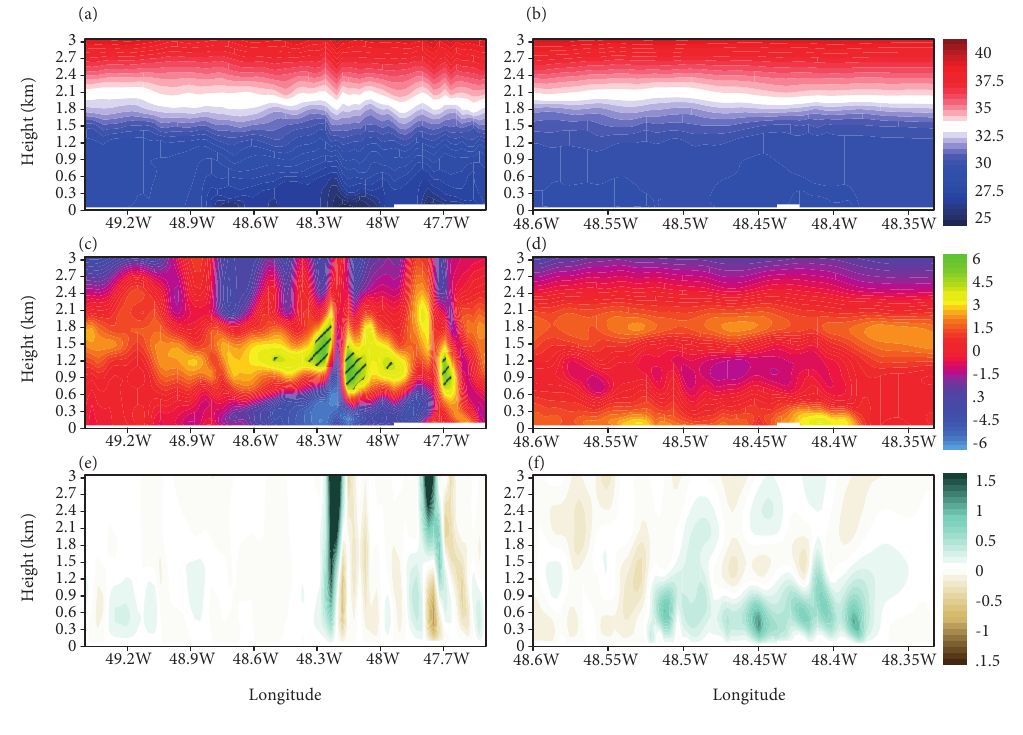
Figure 10. Vertical cross-section at 20 UTC for transects AB (left) and EF (right) for the variables potential temperature (a, b), meridional wind (c, d), and vertical velocity (e, f). The hatched areas represent maximum values from 4.5 to 6 m.s -1 in the meridional component of the